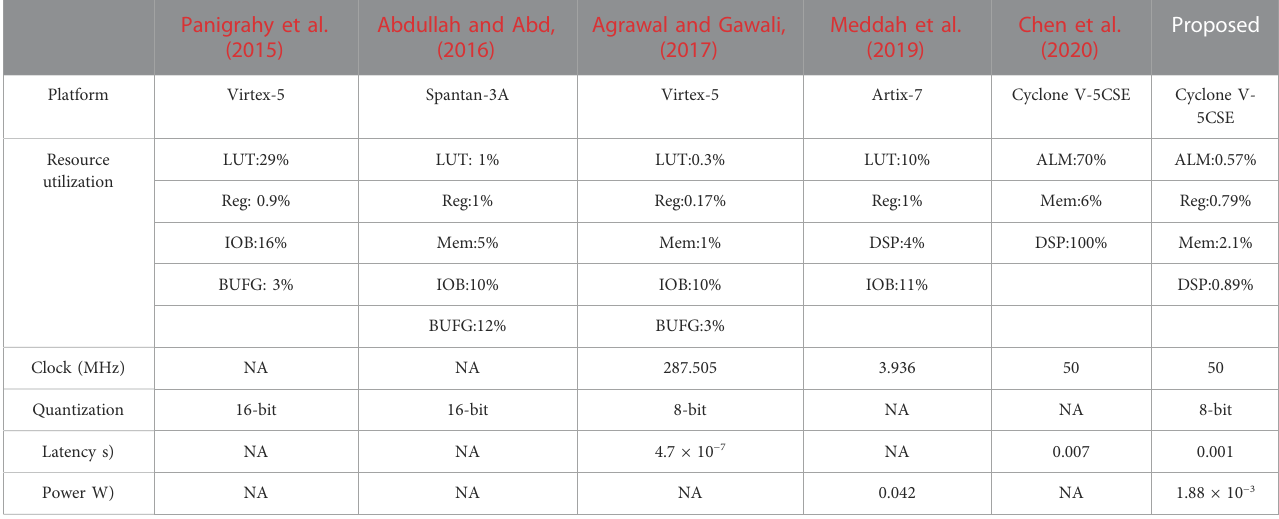
TABLE 4 Comparison with existing FPGA accelerators about heart rate estimation. Panigrahy et al.